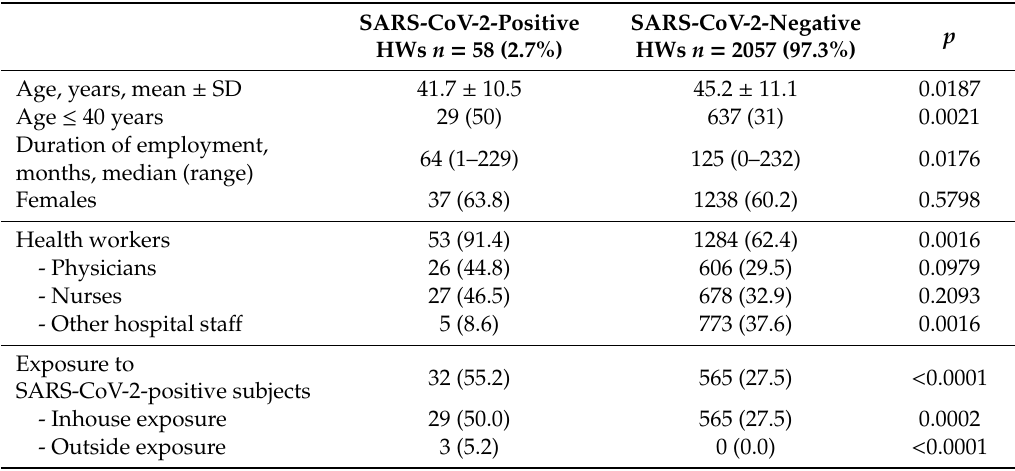
Table 1. Comparison between main characteristics of the RT-PCR SARS-CoV-2-positive and -negative health care workers